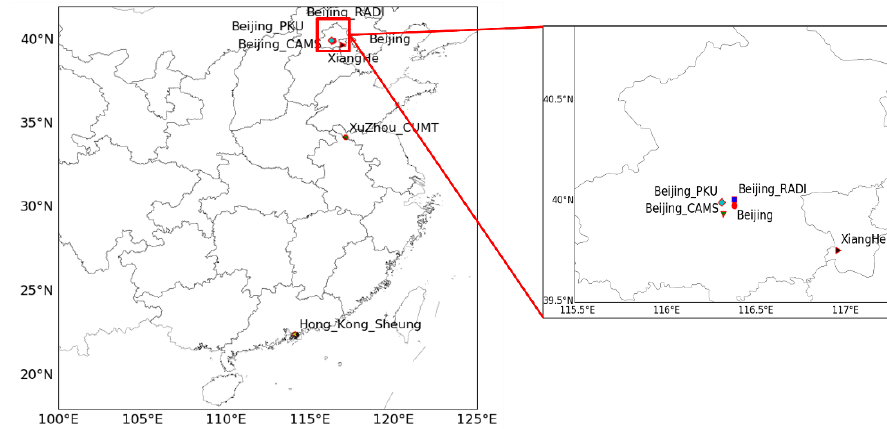
Figure A1. Distribution of the AERONET sites.